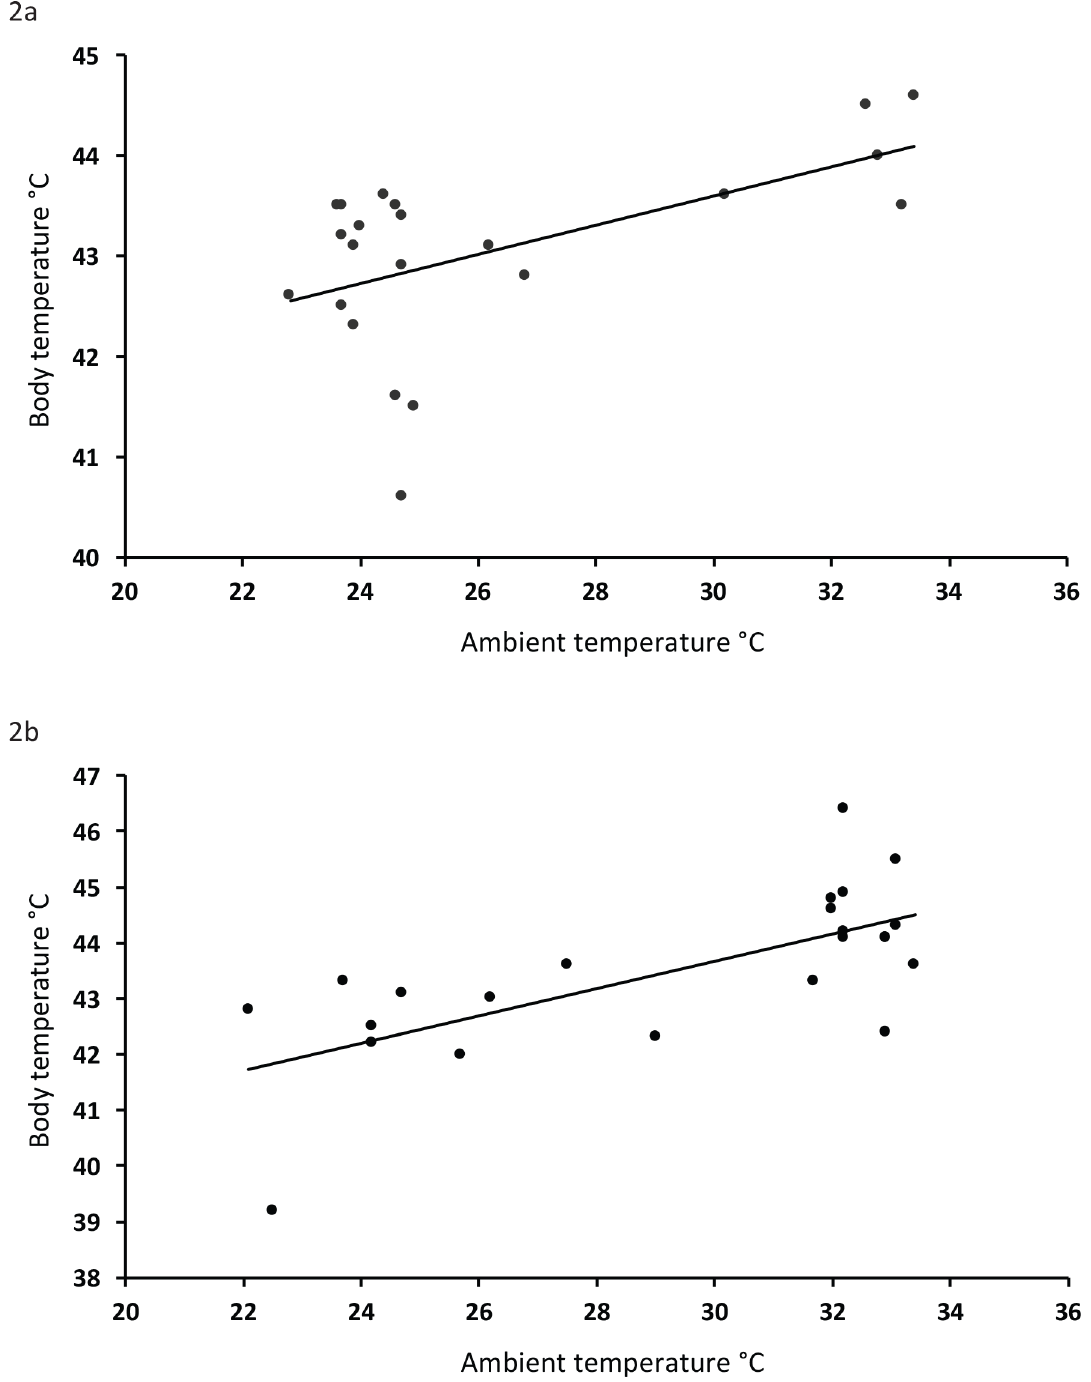
Fig 2. Relationship between ambient temperature in the shade and body temperature. Data from 22 individual red- cheeked cordon-bleus (A) and 23 individual red-billed firefinches (B). Equation of the line (A): Body temperature = 39.3 + 0.14(ambient temperature); R 2 = 0.30, (B) Body temperature = 36.3 + 0.24(ambient temperature); R 2 = 0.47.